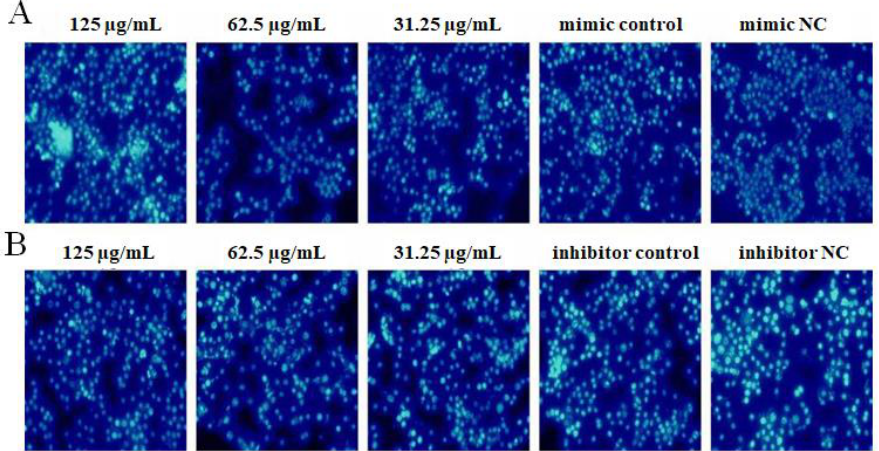
Figure 7. The effect of OPL on cell apoptosis. ( A ): Apoptosis level in the transfected miR-4796 mimic group (×200); ( B ): apoptosis level in the transfected miR-4796 inhibitor group (×200).